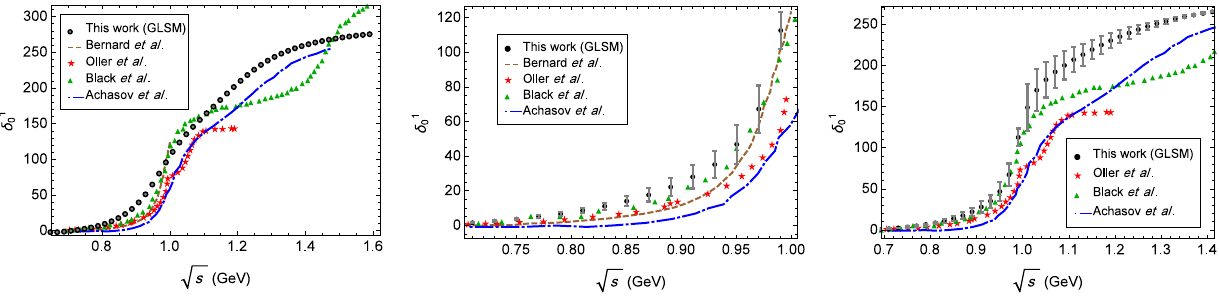
Fig. 11 Left figure shows phase shift computed (with the specific inputs A 3 / A 1 = 30 and m [ π( 1300 ) ] = 1 . 38 GeV) from the K-matrix unitarized s-wave πη → πη scattering amplitude in GLSM and com- pared with predictions by Bernard et al. [147], Oller et al. [155], Black etal.[138]andAchasovetal.[150].TheaveragedpredictionsofGLSM (circles)togetherwithuncertaintiesstemmingfromvariationsof A 3 / A 1